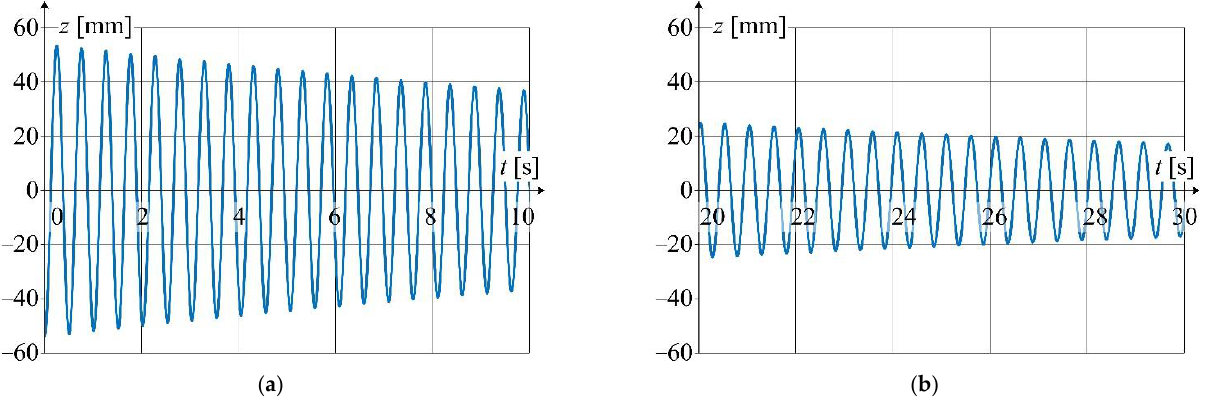
Figure 18. Detailed graphs of displacement waveform (Figure 17): ( a ) for the first 10 s of oscillation; ( b ) for 20 to 30 s of oscillation time.